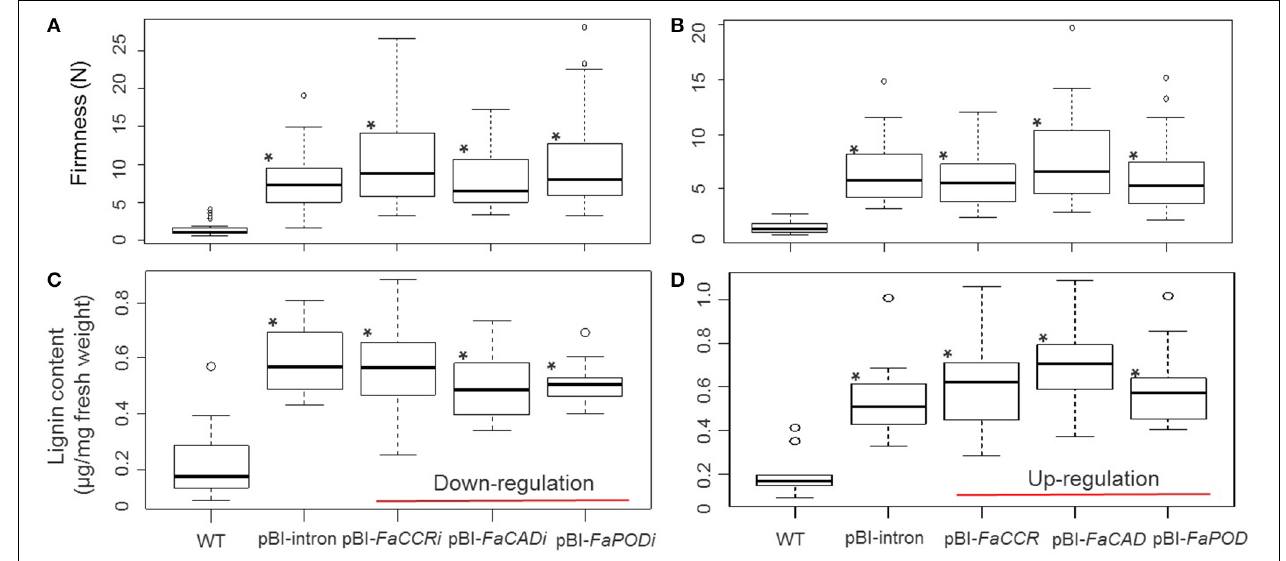
FIGURE 6 | Fruit firmness (A,B) and lignin content (C,D) of individual FaCCR- , FaCAD- , FaPOD -downregulation (A,C) and -upregulation (B,D) in F . × ananassa cv. Elsanta. (A) Firmness of WT (wild type; n = 26), control fruits (pBI-intron; n = 41), and down-regulated fruits (pBI- FaCCRi ; n = 32, pBI- FaCADi ; n = 30, pBI- FaPODi ; n = 35); (B) Firmness of WT ( n = 30), pBI-intron ( n = 41), and up-regulated fruits (pBI -FaCCR ; n = 39, pBI- FaCAD ; n = 35,